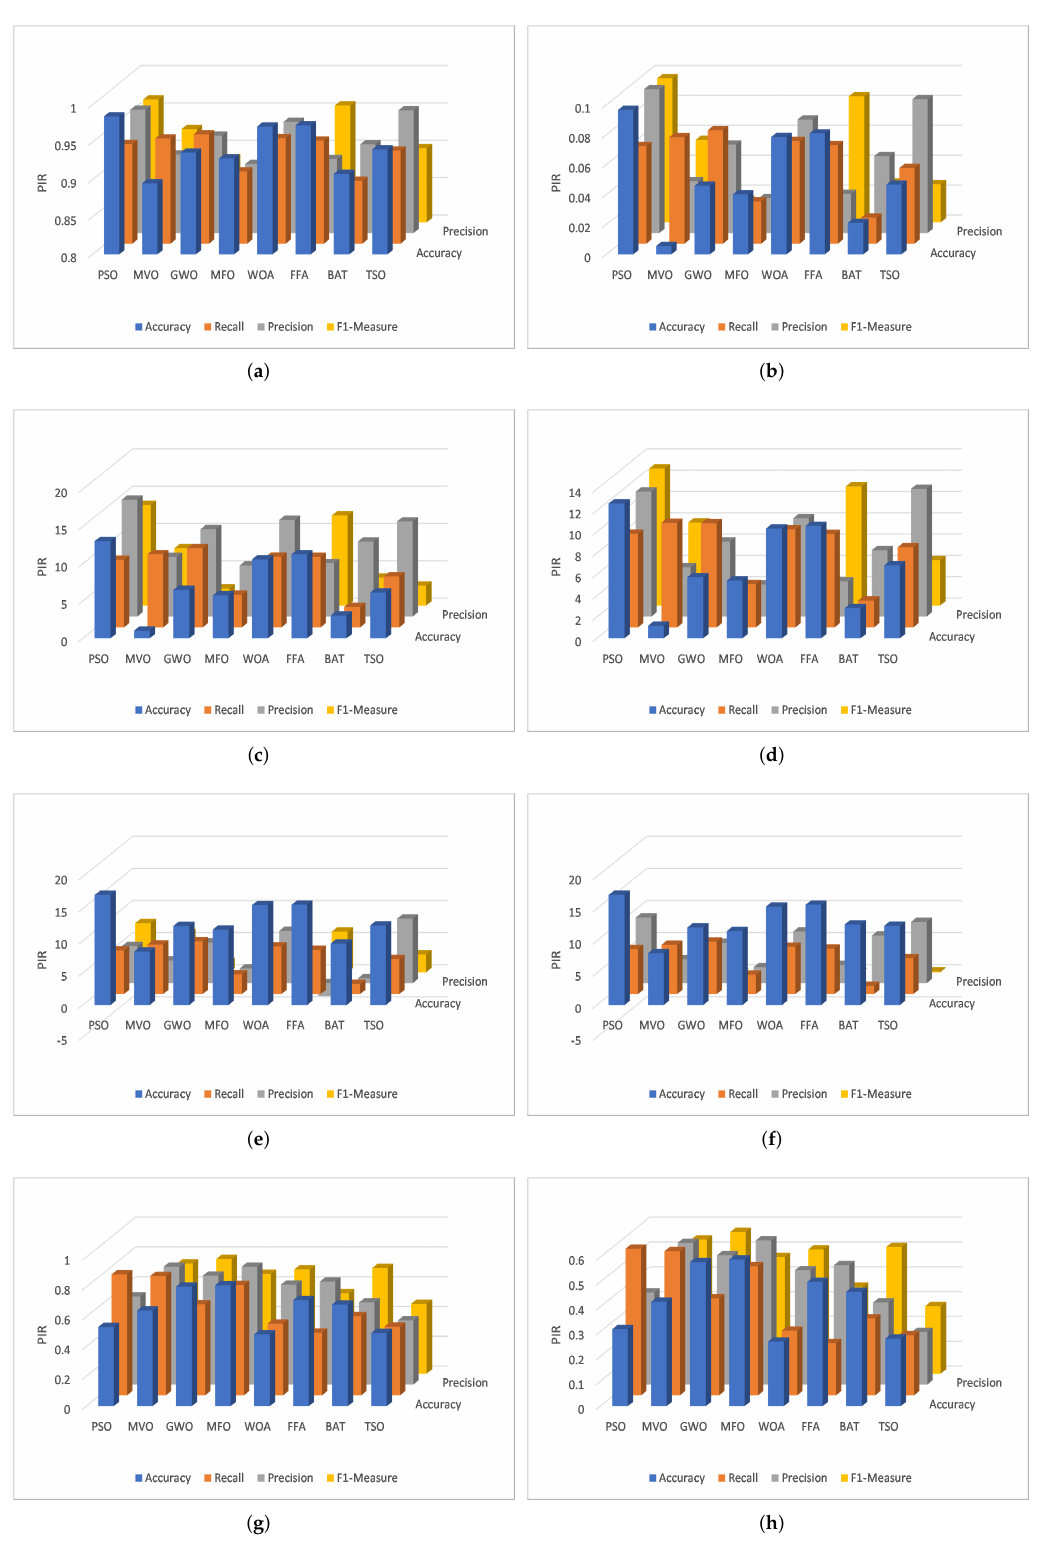
Figure 7. PIR for multi-classification of ( a ) Bot-IoT, ( c ) NSL-KDD, ( e ) KDDCup-99, and ( g ) CICIDS- 2017 and binary classification of ( b ) Bot-IoT, ( d ) NSL-KDD, ( f ) KDDCup-99, ( h )